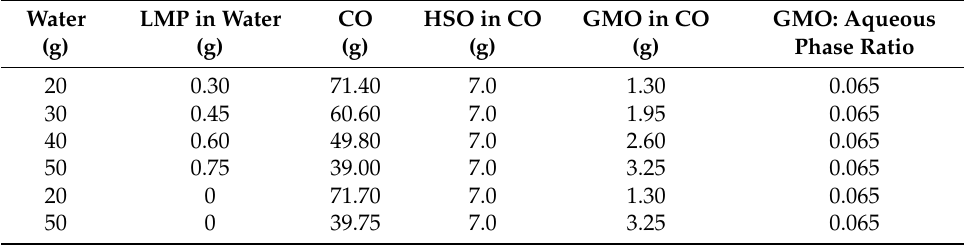
Table 1. W/O emulsion composition for all water contents in 100 g. The last two rows show the composition of control W/O emulsions without LMP in the aqueous phase. LMP: low methoxyl pectin; CO: canola oil; HSO: fully hydrogenated soybean oil; GMO: glycerol